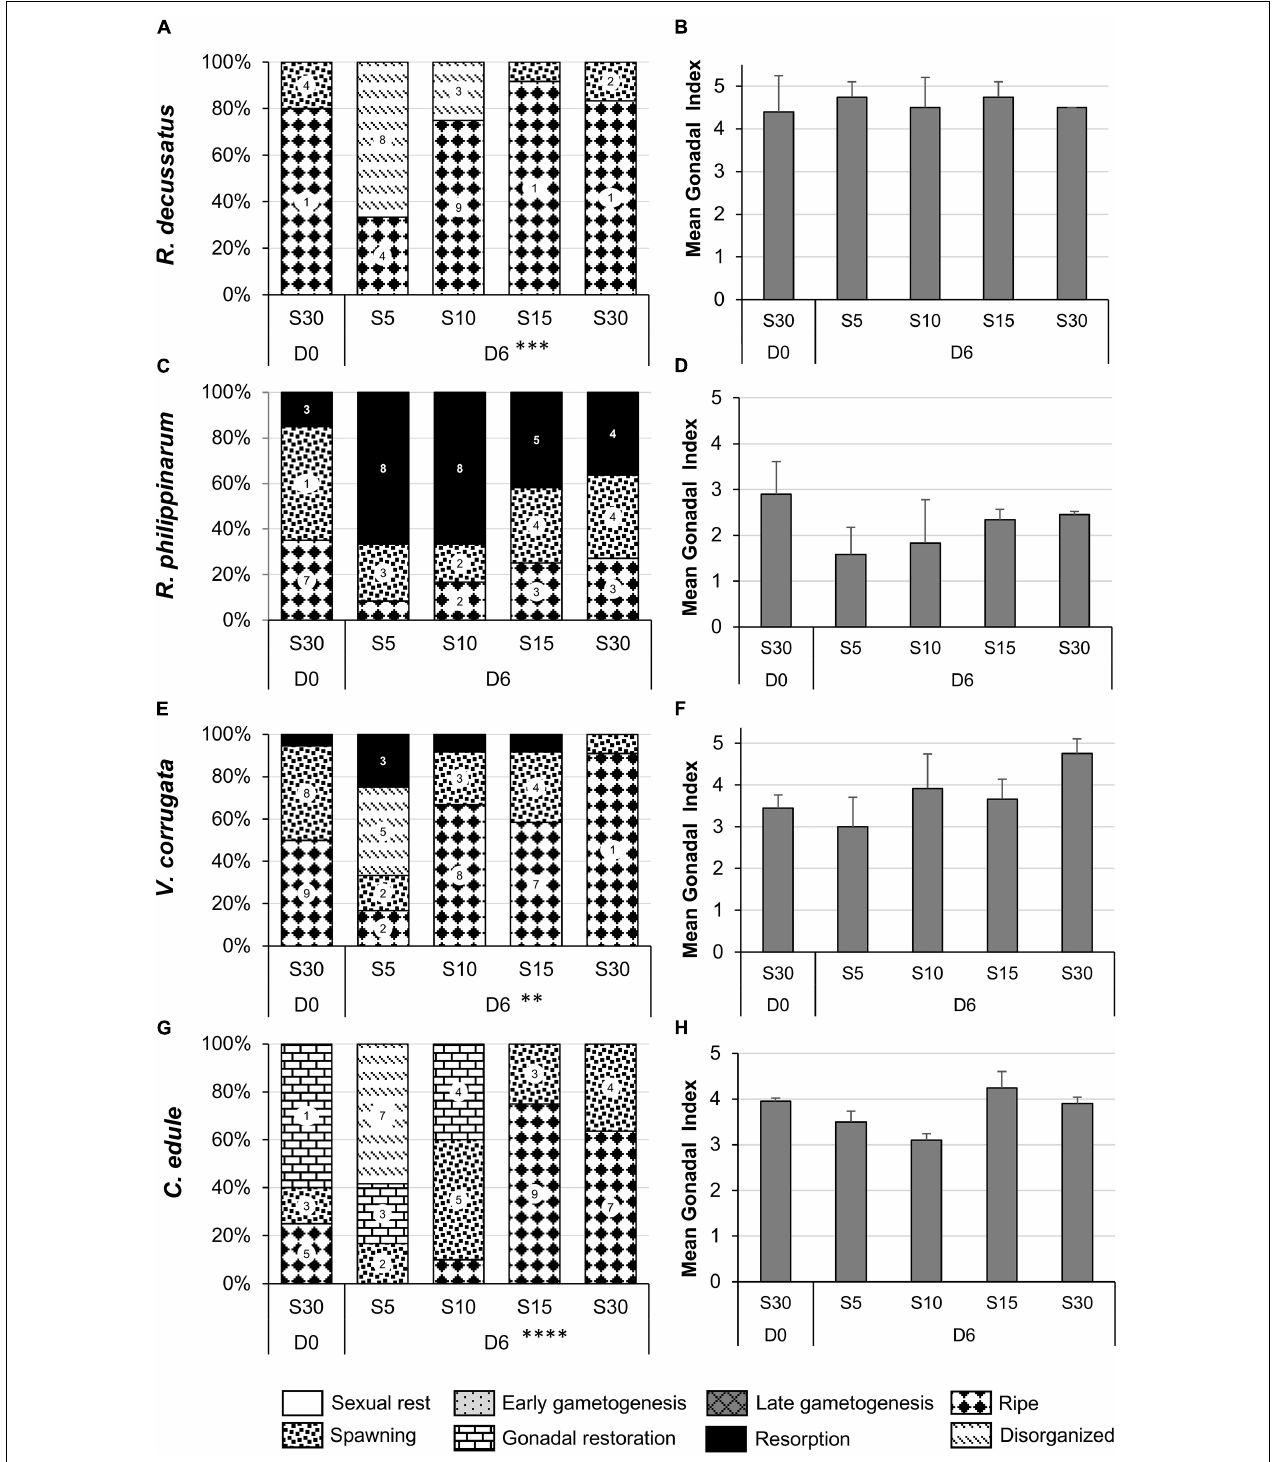
FIGURE 7 | Gonadal stages (percentage) (A,C,E,G) and gonadal index (mean + SD) (B,D,F,H) in the May low salinity experiment in each salinity treatment at the beginning of the experiment (D0) and after six days of stress (D6). Salinity treatments: S5 corresponds to a salinity ramp from 5 to 20, S10 from 10 to 25, S15 from 15 to 30, and S30 control. (A,B) Ruditapes decussatus ; (C,D) Ruditapes philippinarum ; (E,F) Venerupis corrugata ; (G,H) Cerastoderma edule . Asterisks refer to the significance of the multinomial logistic regressions: ∗∗ p < 0.01; ∗∗∗ p < 0.001; ∗∗∗∗ p < 0.0001. Number in the bars indicate number of individual clams within categories. Categories without number but present in the graph means one individual.